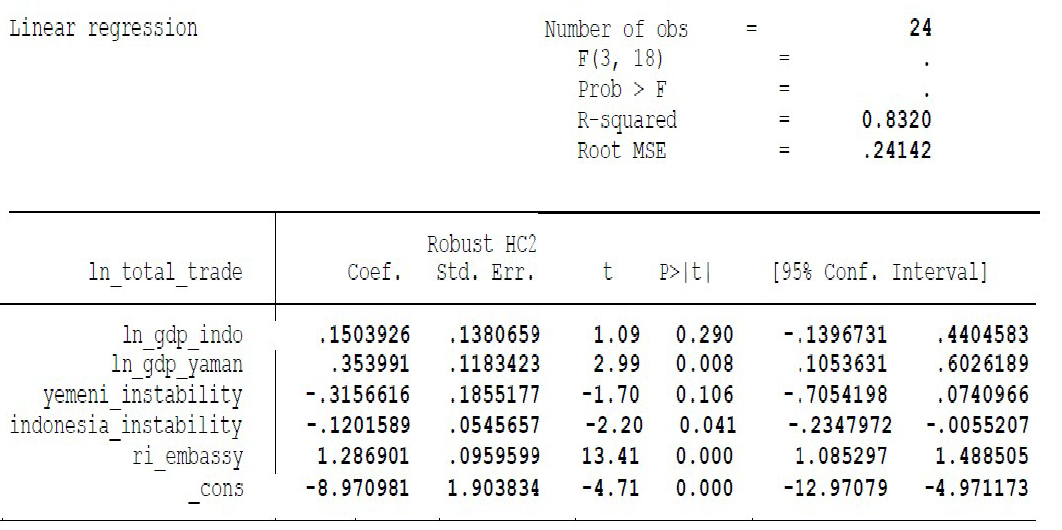
Table 2. Regression Analysis of Factors Affecting Bilateral Trade Value Indonesia – Yemen During the Period